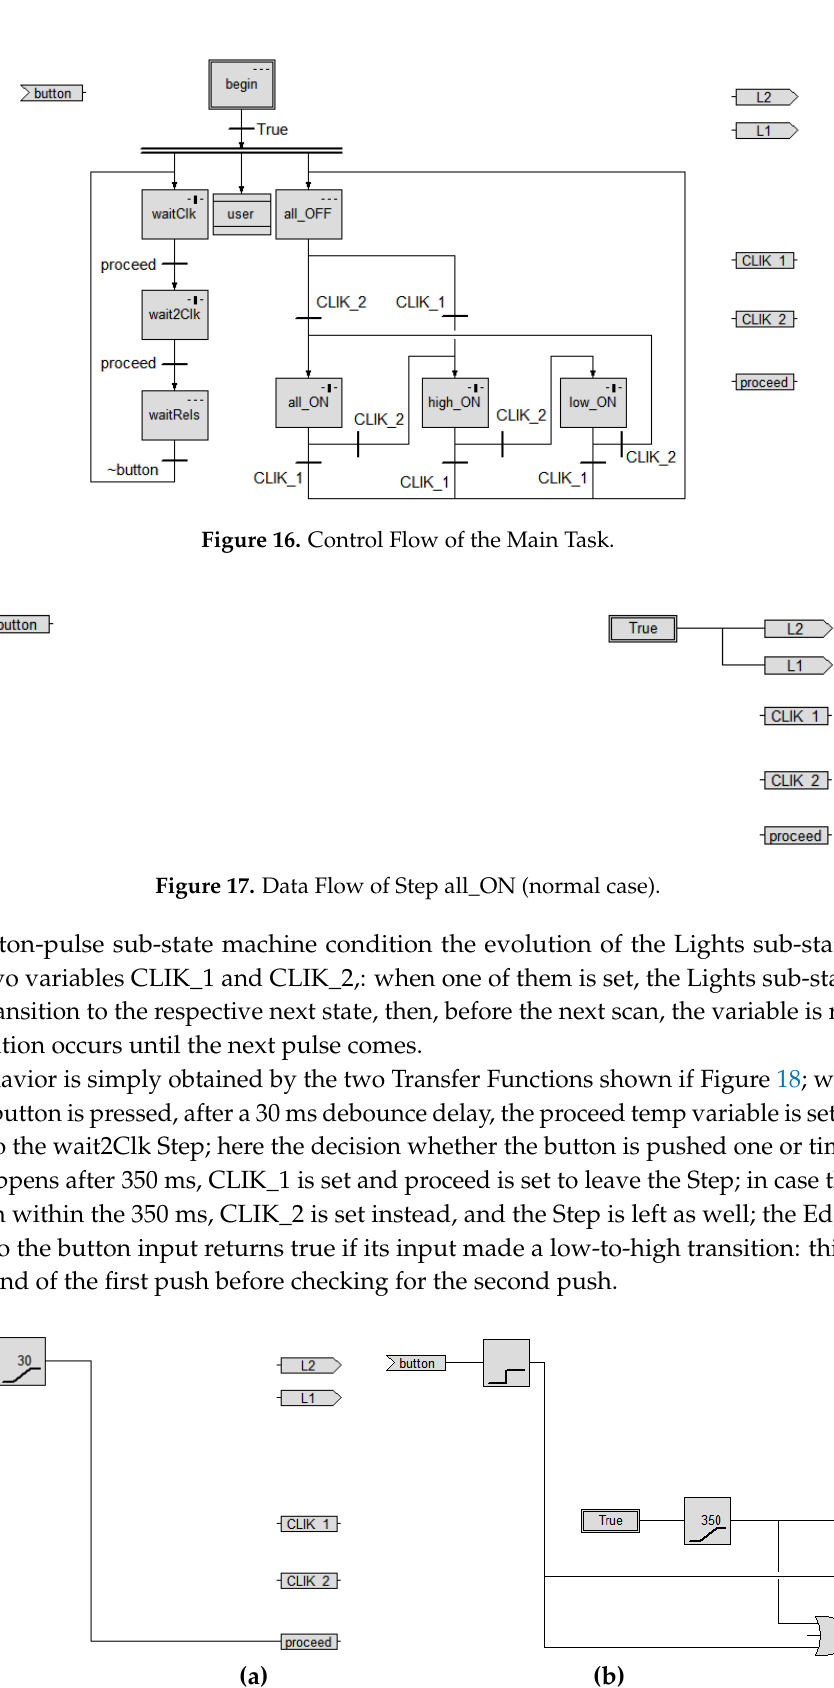
Figure 18. Data Flow of Steps waitClk ( a ) and wait2Clk ( b ).